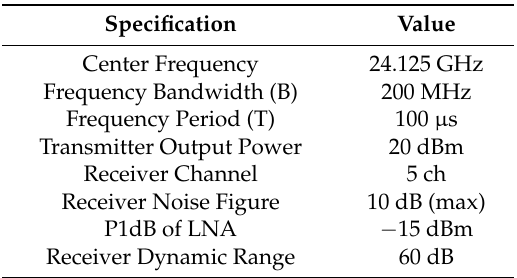
Table 2. Specifications of the developed 24-GHz transceiver and